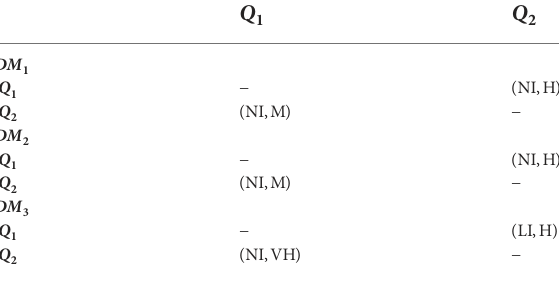
TABLE 7 Pair influence degree of the sub-criteria of Q 1 for three decision makers. C 1